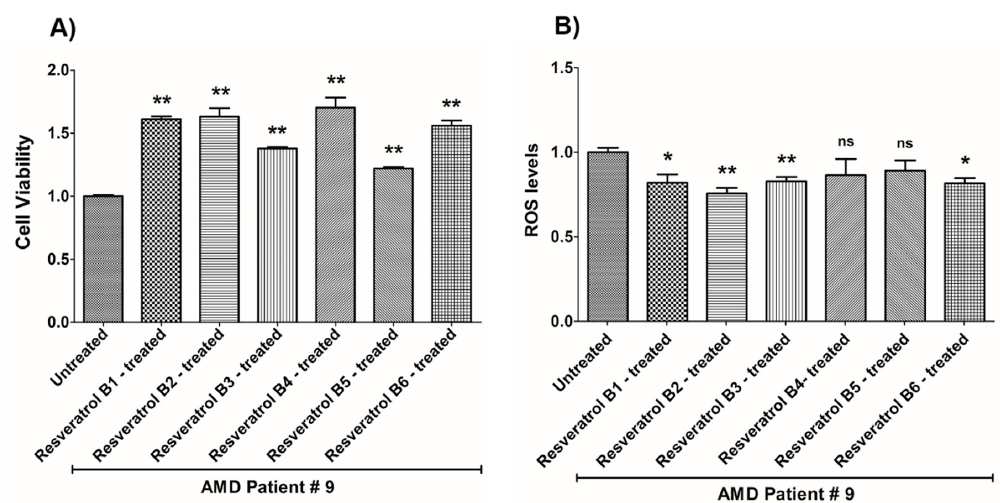
Figure 9. Effects of resveratrol formulations on cell viability ( A ) and ROS levels ( B ) in AMD patient #8. Bar 1—untreated AMD cells; Bar 2—resveratrol B1-treated AMD cells; Bar 3—resveratrol B2-